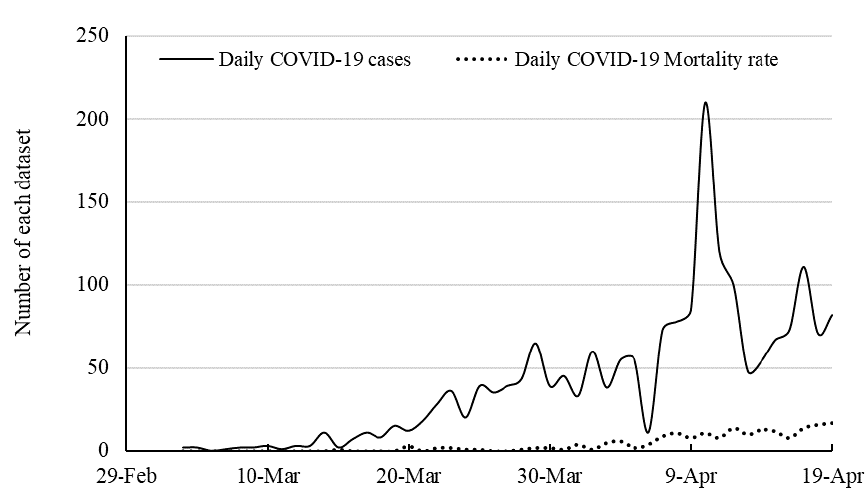
Figure 2. Daily statistics for the number of cases and mortality rate of COVID-19.